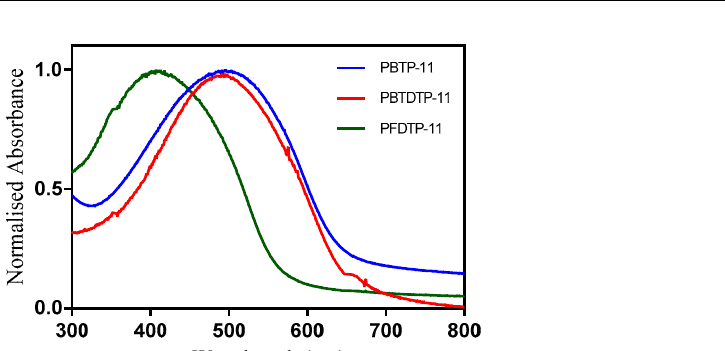
Figure 1. Normalized UV-vis absorption spectra of PBTP-11, PBTDTP-11and PFDTP-11 in ( a ) chloroform solutions; and ( b ) thin films .